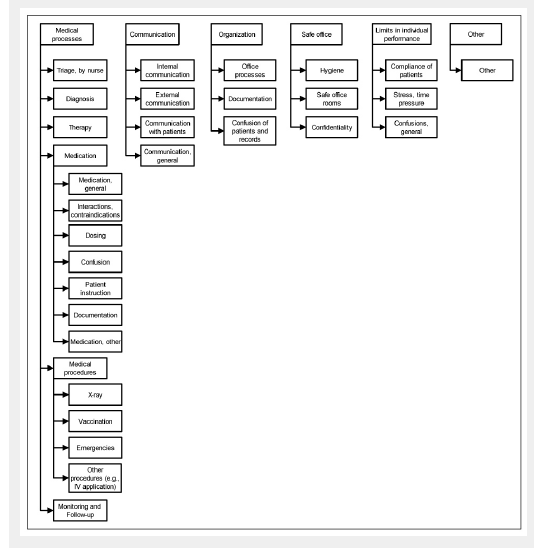
Figure 1 Category system for coding citations of priority threats to patient safety.